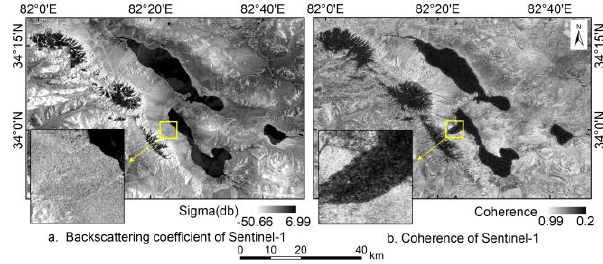
Figure 2. Backscattering coefficient and coherence images from Sentinel-1